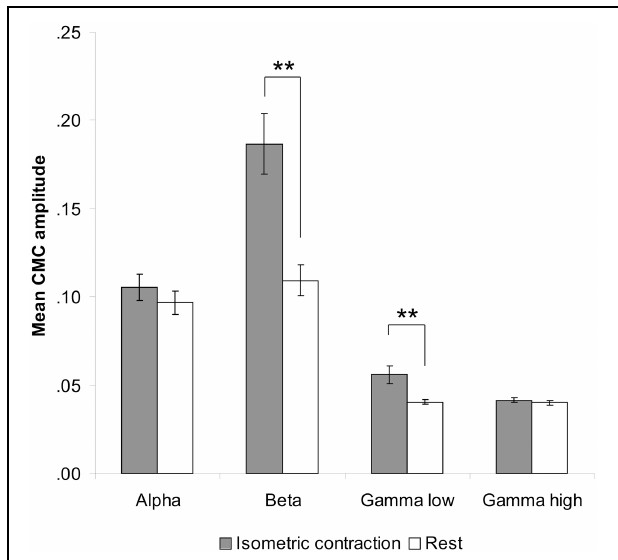
FIGURE 2 | Contralateral CMC amplitude during isometric contraction and rest prior to tACS. A significant increase of CMC amplitude during isometric contraction compared to rest was only found in the beta (13–30Hz) and low gamma (30–45Hz) band. Error bars indicate standard error of mean. Asterisks denote significant p -values <